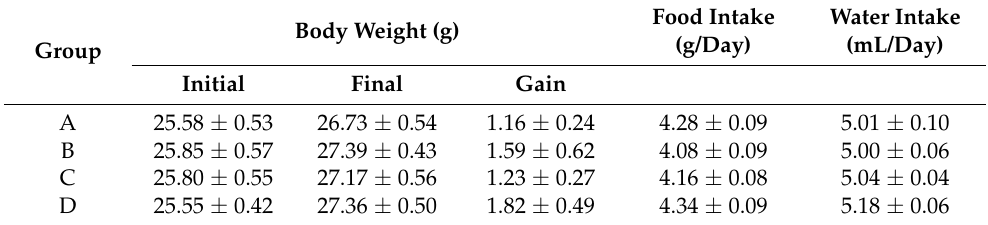
Table 2. Effects of SPE treatment on body weight, food intake, and water intake in female SAMP8 mice.